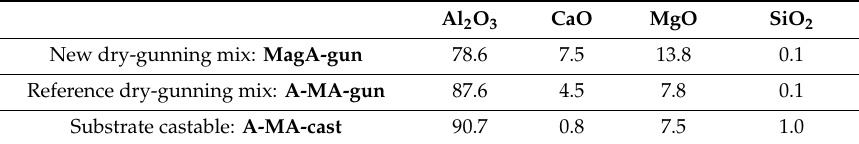
Table 3. Chemical composition (wt%) of refractory materials for steel ladle